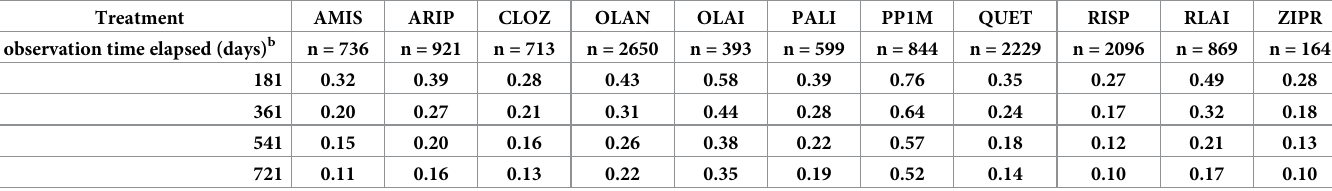
Table 2. Proportion of patients continuing newly initiated antipsychotic initiation during the 2-year follow-up period a . Treatment observation time elapsed (days) b